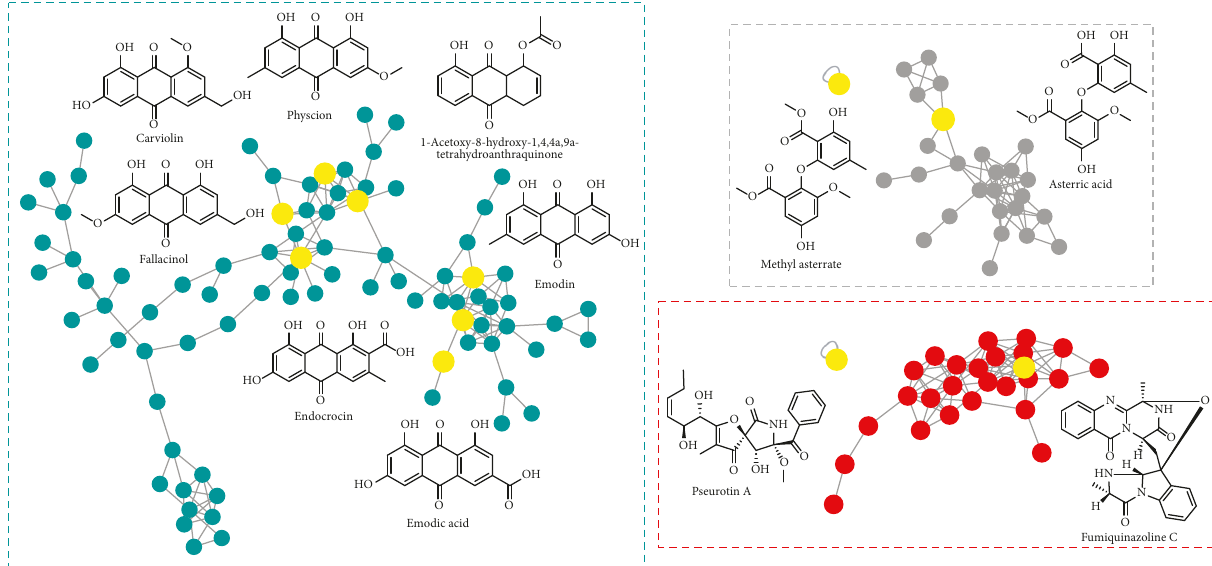
Figure 3: Subnetwork of tandem MS/MS molecular working for